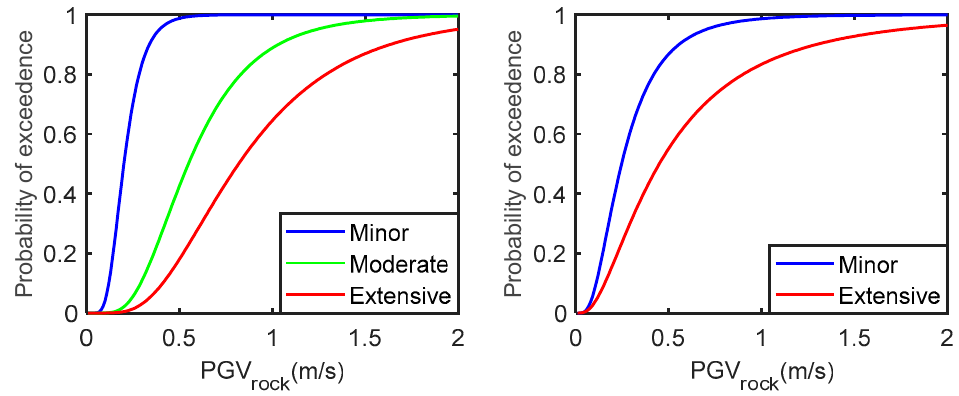
Figure 9. Analytical fragility curves developed to assess the seismic vulnerability of strategic port infrastructure components: ( left ) for the pile-supported wharf; ( right ) for cranes.